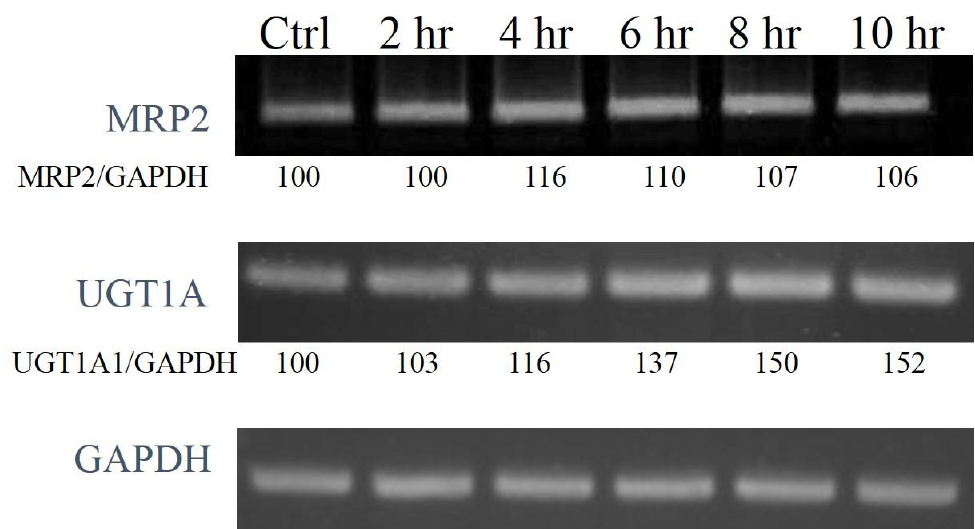
Figure 5. The concentration-dependent study of PP2Ac methylation status under 6,7-di- prenoxycoumarin ( 50 ) treatment. Hep3B cells (1 × 10 6 ) were treated with 50 (5, 10, 20 and 40 μM) for 24 h. Treated cell lysates were prepared as described in the Methods section and methyl-PP2Ac expression was analyzed by western blot.